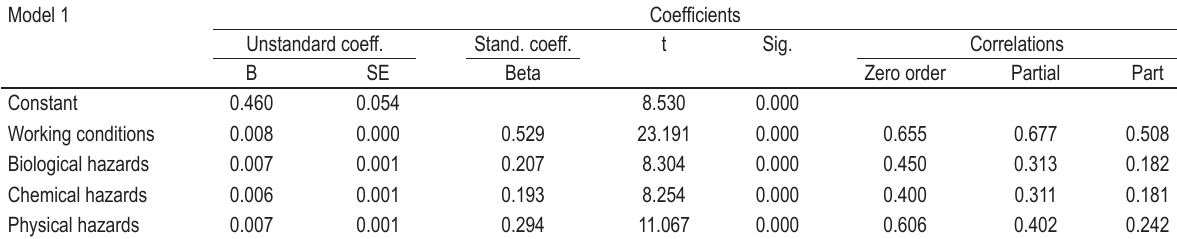
TABLE 7. Testing the coefficients of the model Model